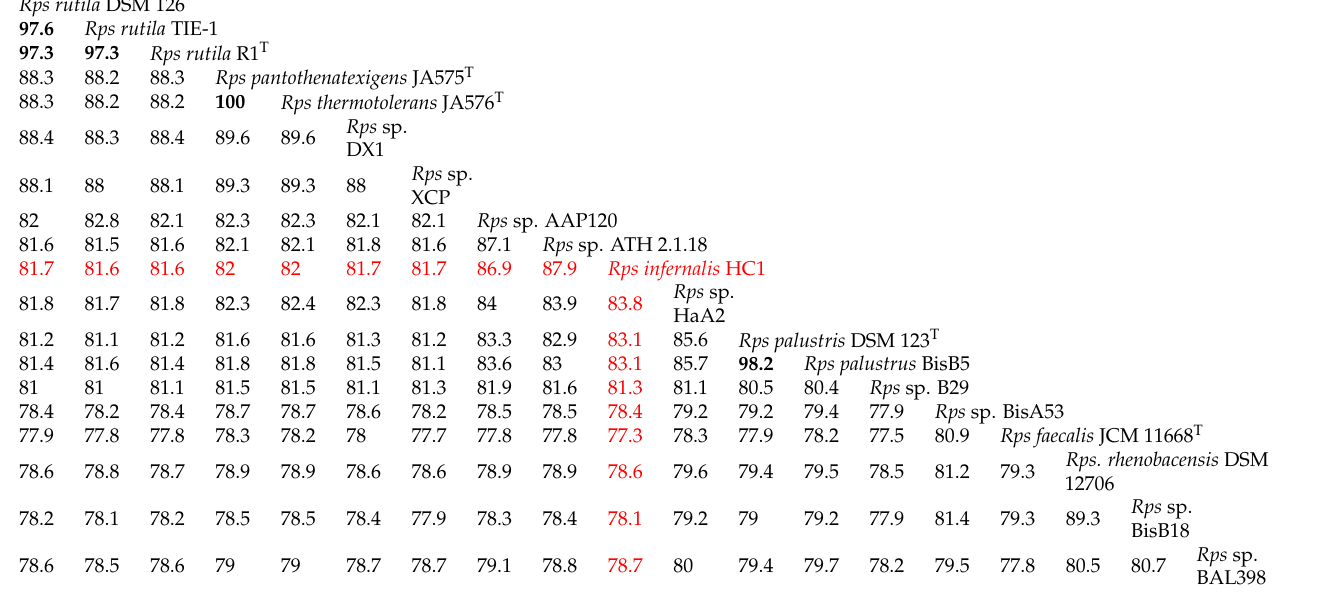
Table 2. Average Nucleotide Identity (ANIb) comparison of Rhodopseudomonas strains. ANIb values above the species level cutoff (>95%) are marked in bold. The HC1 isolate is marked in